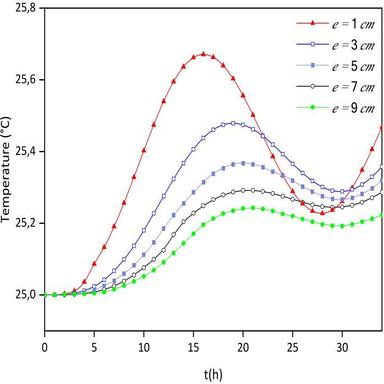
The average temperature on the inner surfaces as a function of the COP40 layer thickness.